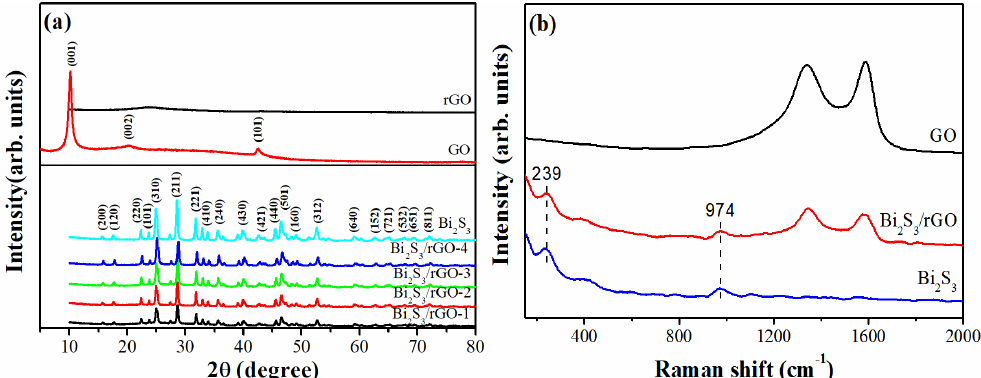
Figure 2. ( a ) The XRD spectra of the GO, rGO, Bi 2 S 3 , and Bi 2 S 3 /rGO; ( b ) Typical Raman spectra of GO, Bi 2 S 3 , and prepared Bi 2 S 3 /rGO.